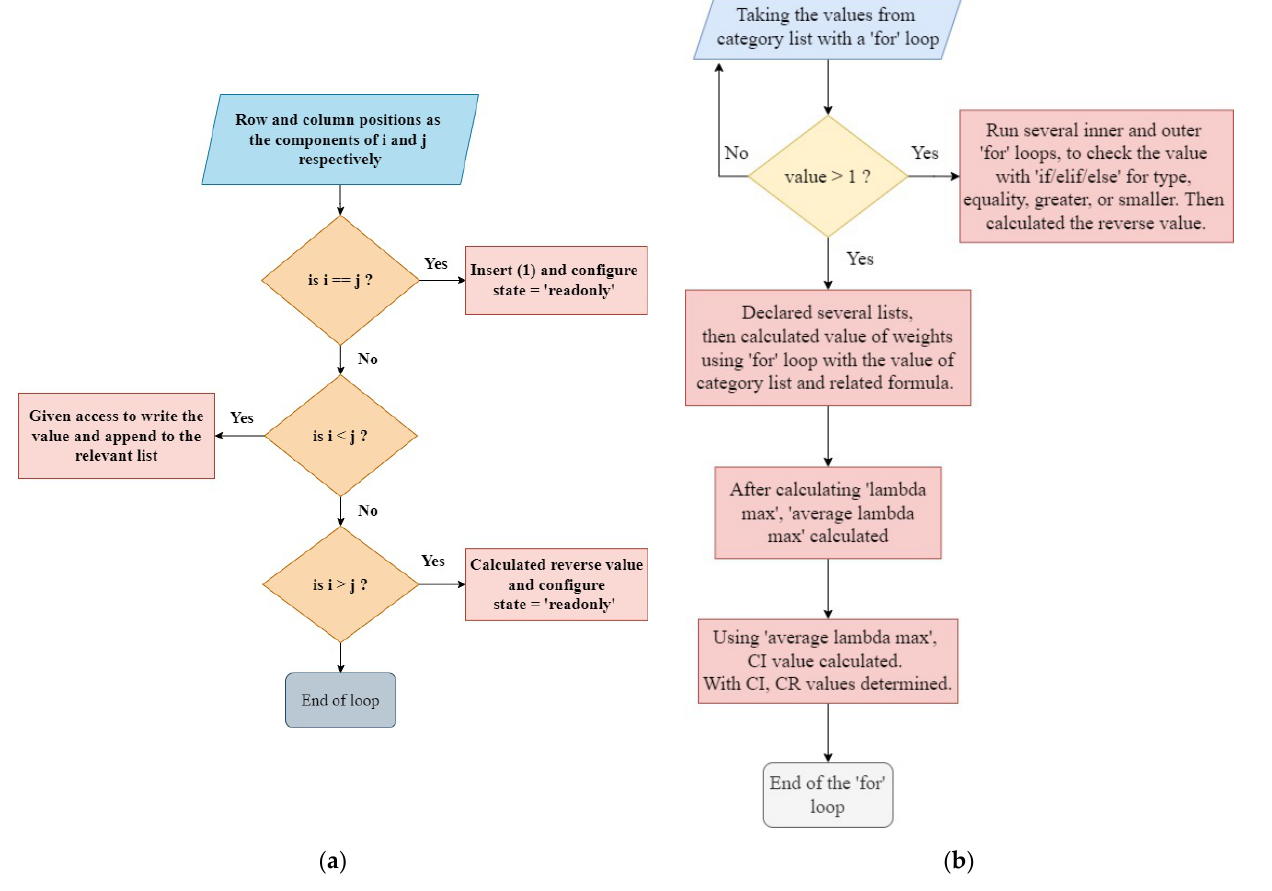
Figure 10. Flowcharts for: ( a ) generating matrices to input and collect values; ( b ) the calculation of weights and consistency indexes.